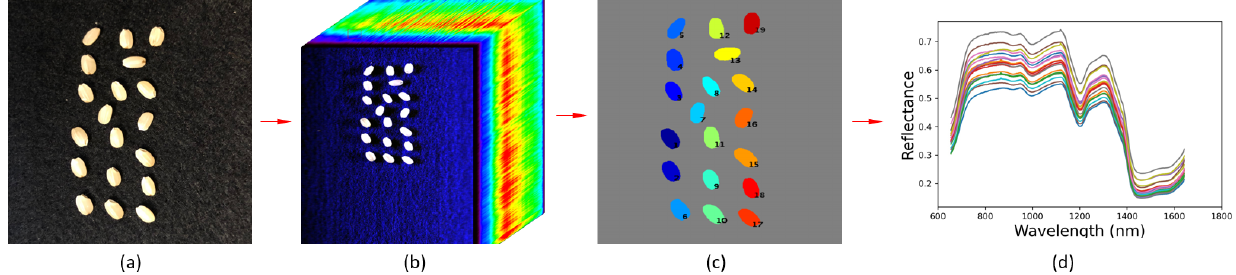
Figure 1. The overall workflow of proposed platform: ( a ) seed sample placement; ( b ) hypercube generation; ( c ) seed segmentation; ( d ) reflectance curves